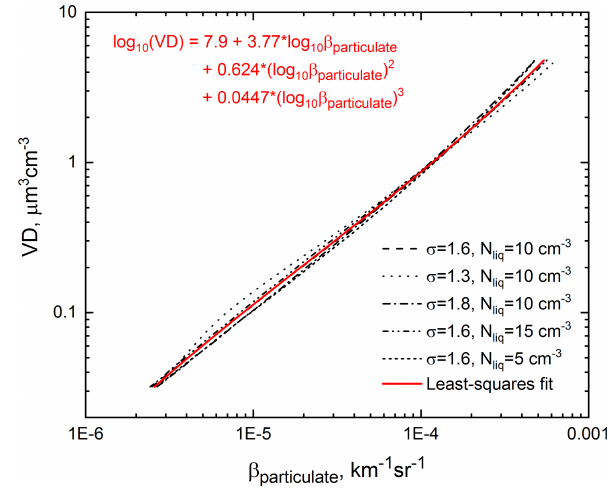
Figure 6. Theoretical particulate surface area density (SAD) vs. β particulate for various combinations of liquid particle number density N liq and lognormal geometric standard deviation σ , along with the third-order polynomial least-squares fit.